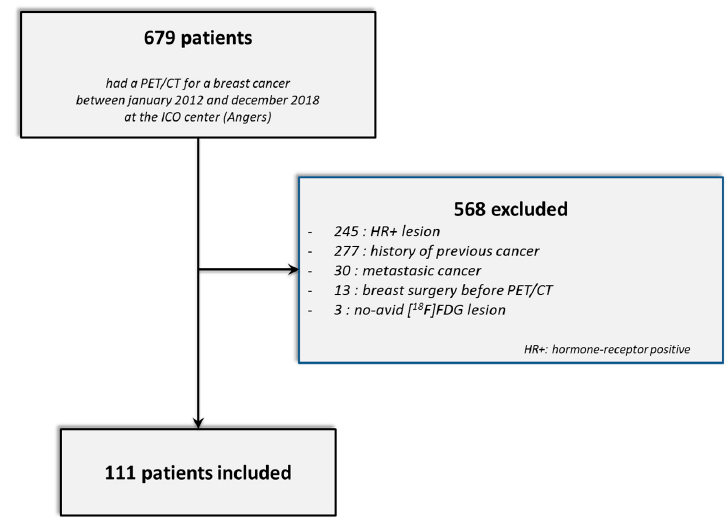
Figure 3. STARD flow diagram.